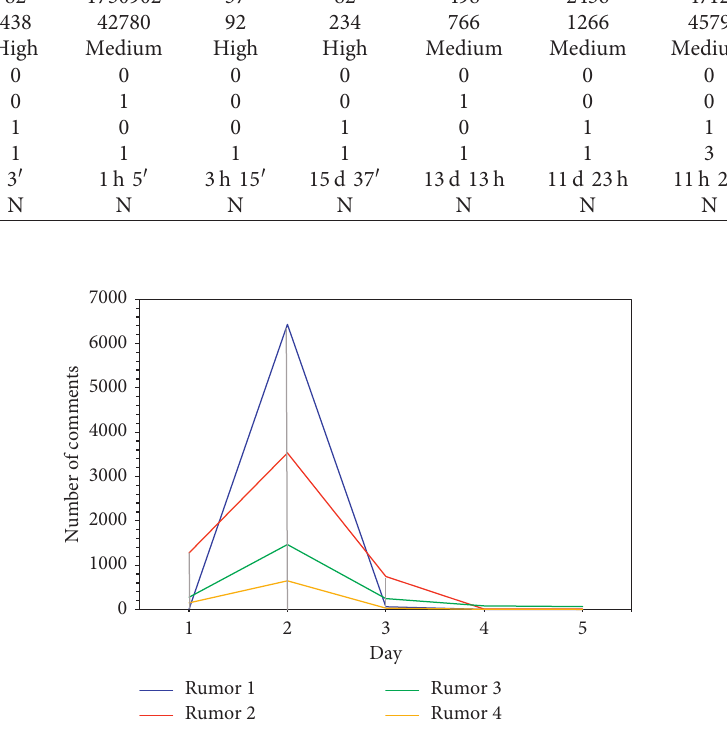
Figure 9: Numbers of comments of five popular rumors vary with